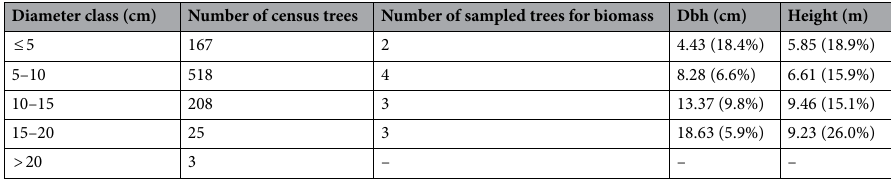
Table 1. Number of census trees and sampled trees for biomass study in each diameter class. Mean diameter at breast height (dbh) and mean tree height of the trees sampled for biomass study with their respective coefficient of variation (%) in brackets are reported for each diameter